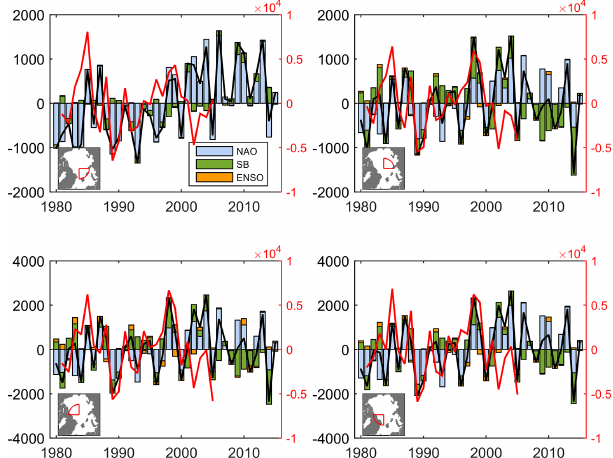
Figure 9. Temporal variability of total BC load anomaly over 90 ◦ longitude segments of the Arctic and between 80 and 90 ◦ N (kgyr − 1 ) related to the circulation patterns IC NAO , IC SB and IC ENSO . The black line is the sum of the three components; the red line (right y axis) is the total BC load anomaly from the FIX2000